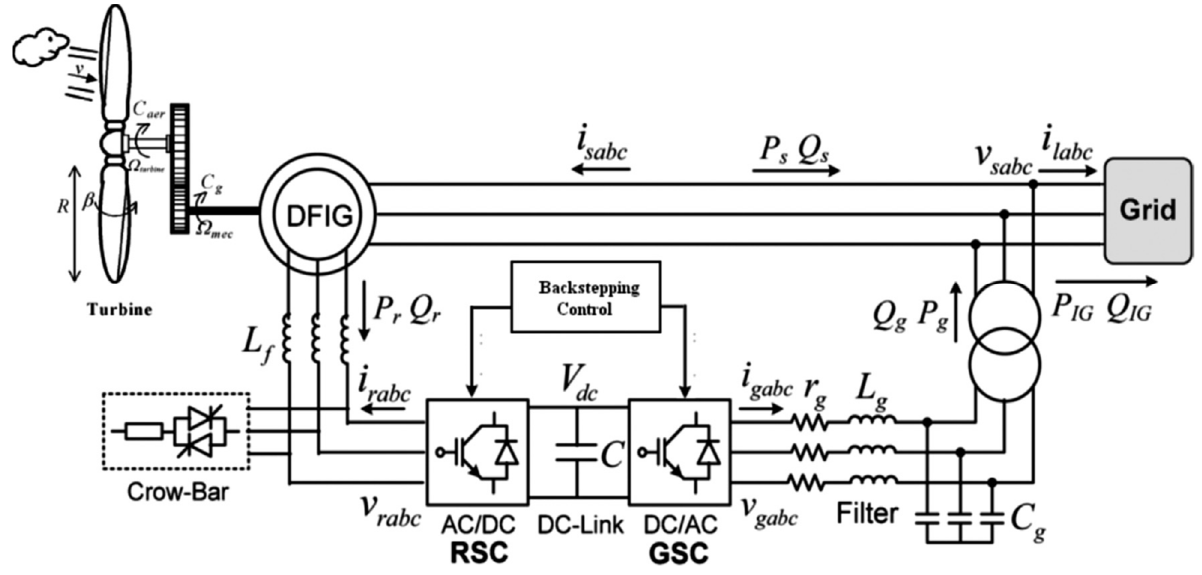
Figure 1. Wind system structure [20].